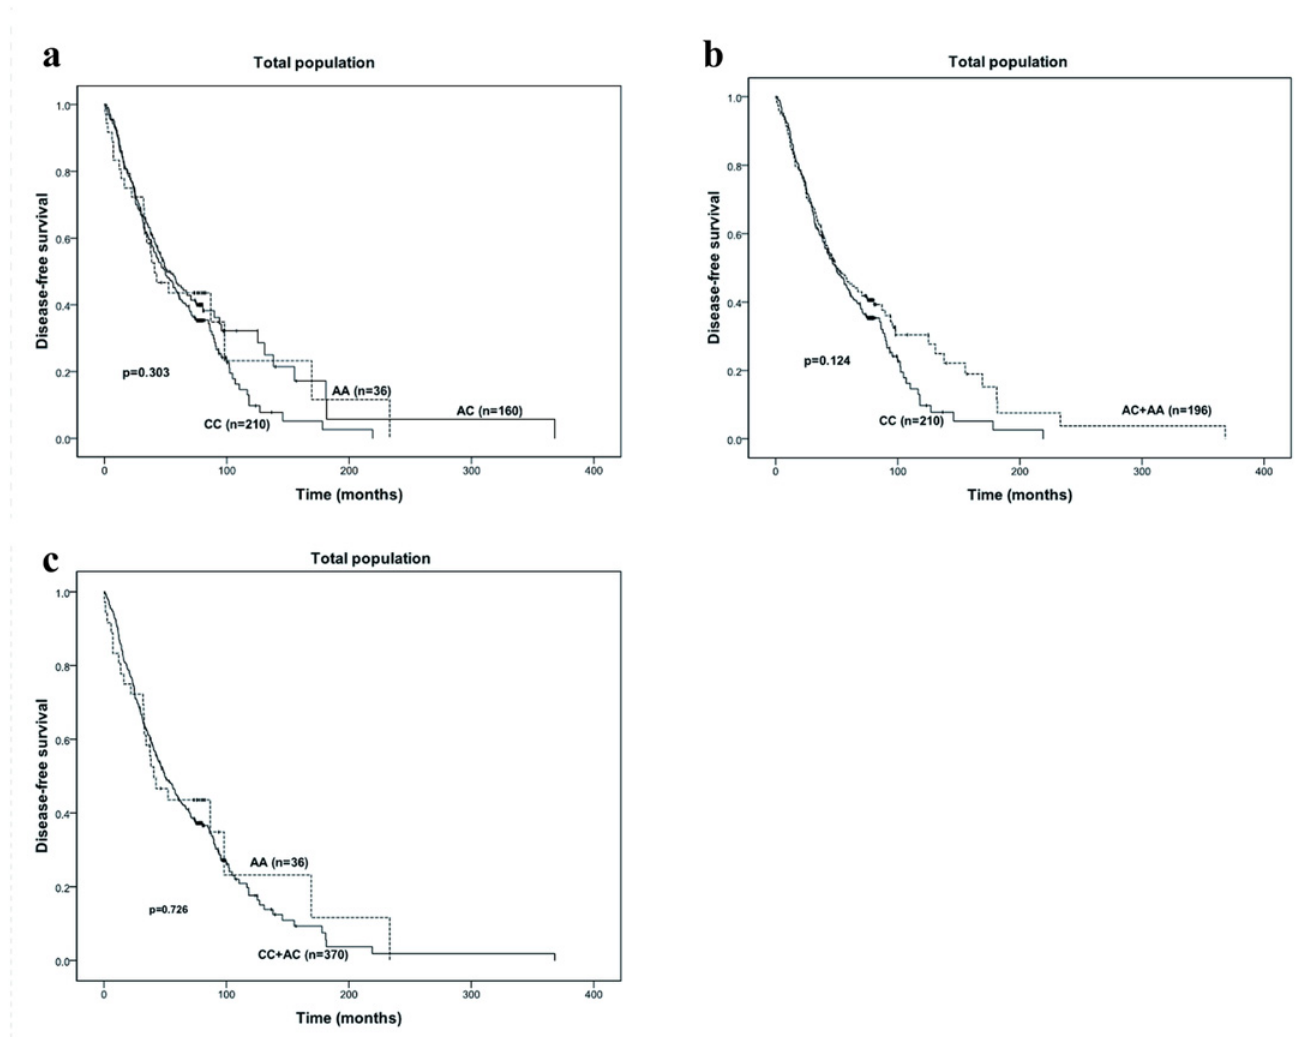
Fig 1. Survival curves for the total patients. a. Disease-free survival of the patients grouped according to CYP19 rs4646 genotypes (CC vs AC vs AA). b. Disease-free survival of the patients grouped by CYP19 rs4646 genotypes (CC vs AC + AA). c. Disease-free survival of the patients subgrouped according to CYP19 rs4646 genotypes (AC+CC vs